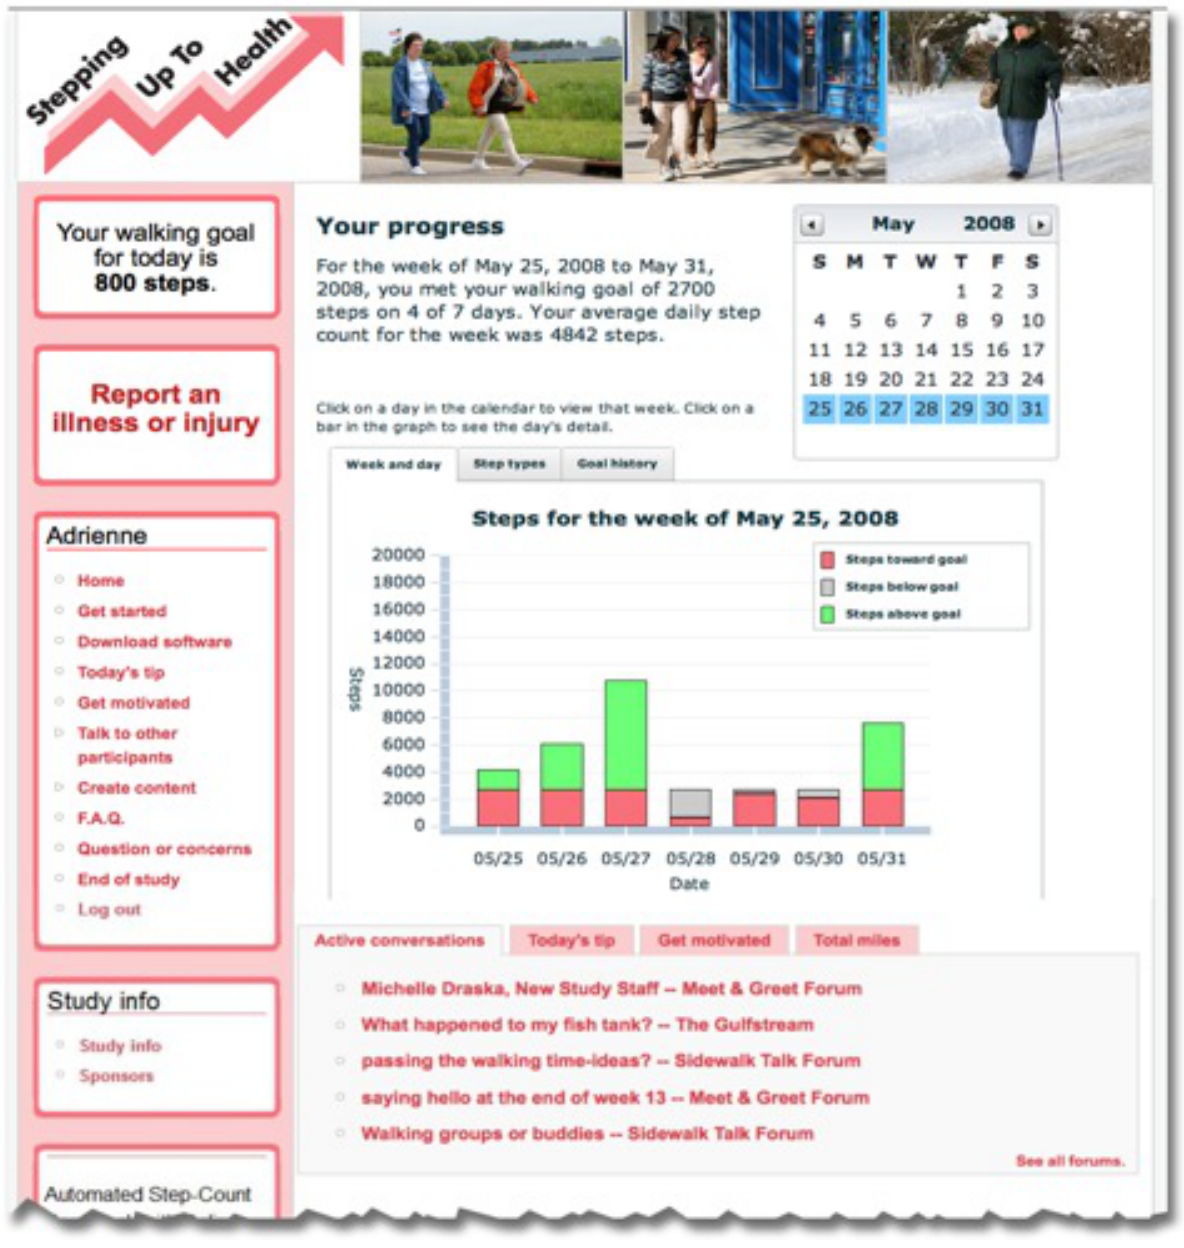
Figure 1. Screenshot of